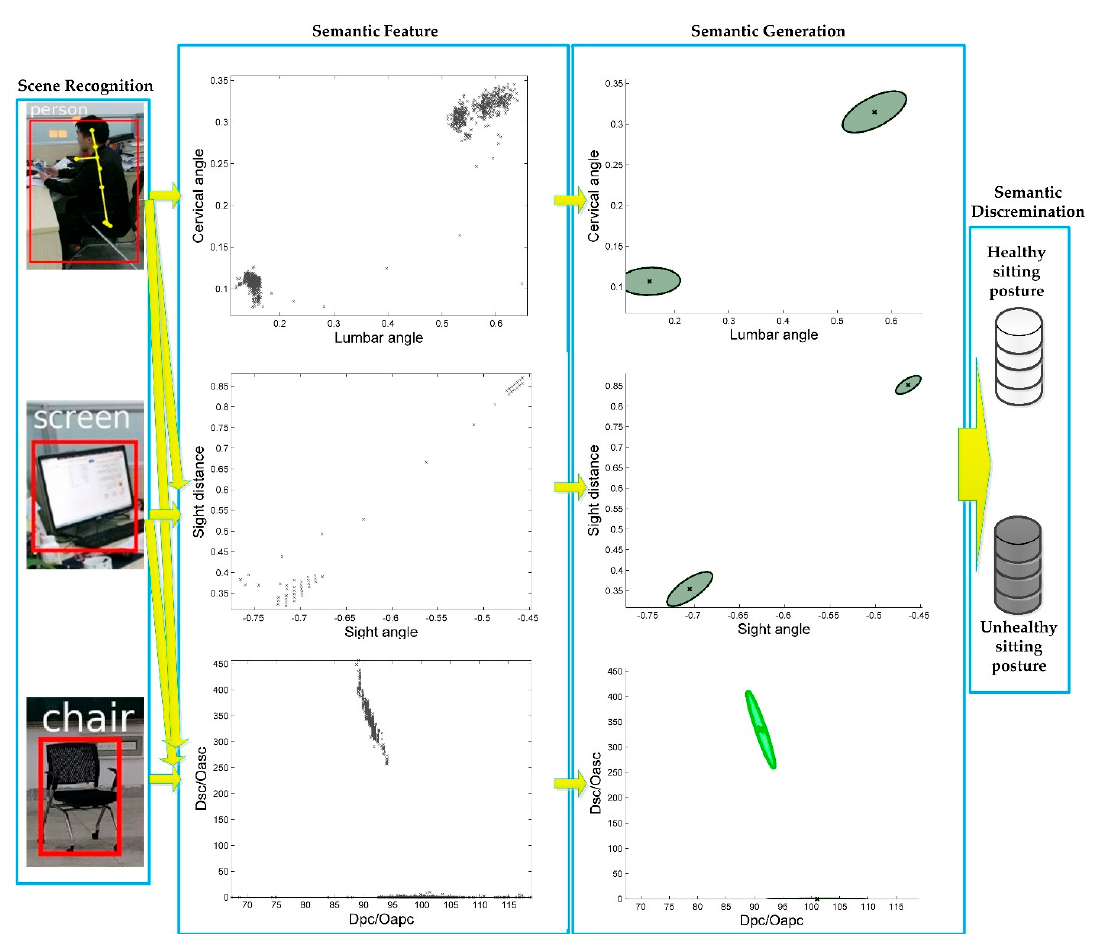
Figure 9. The processing of semantic analysis (i.e., scene recognition, semantic feature extraction and semantic generation) are illustrated for semantic discrimination.